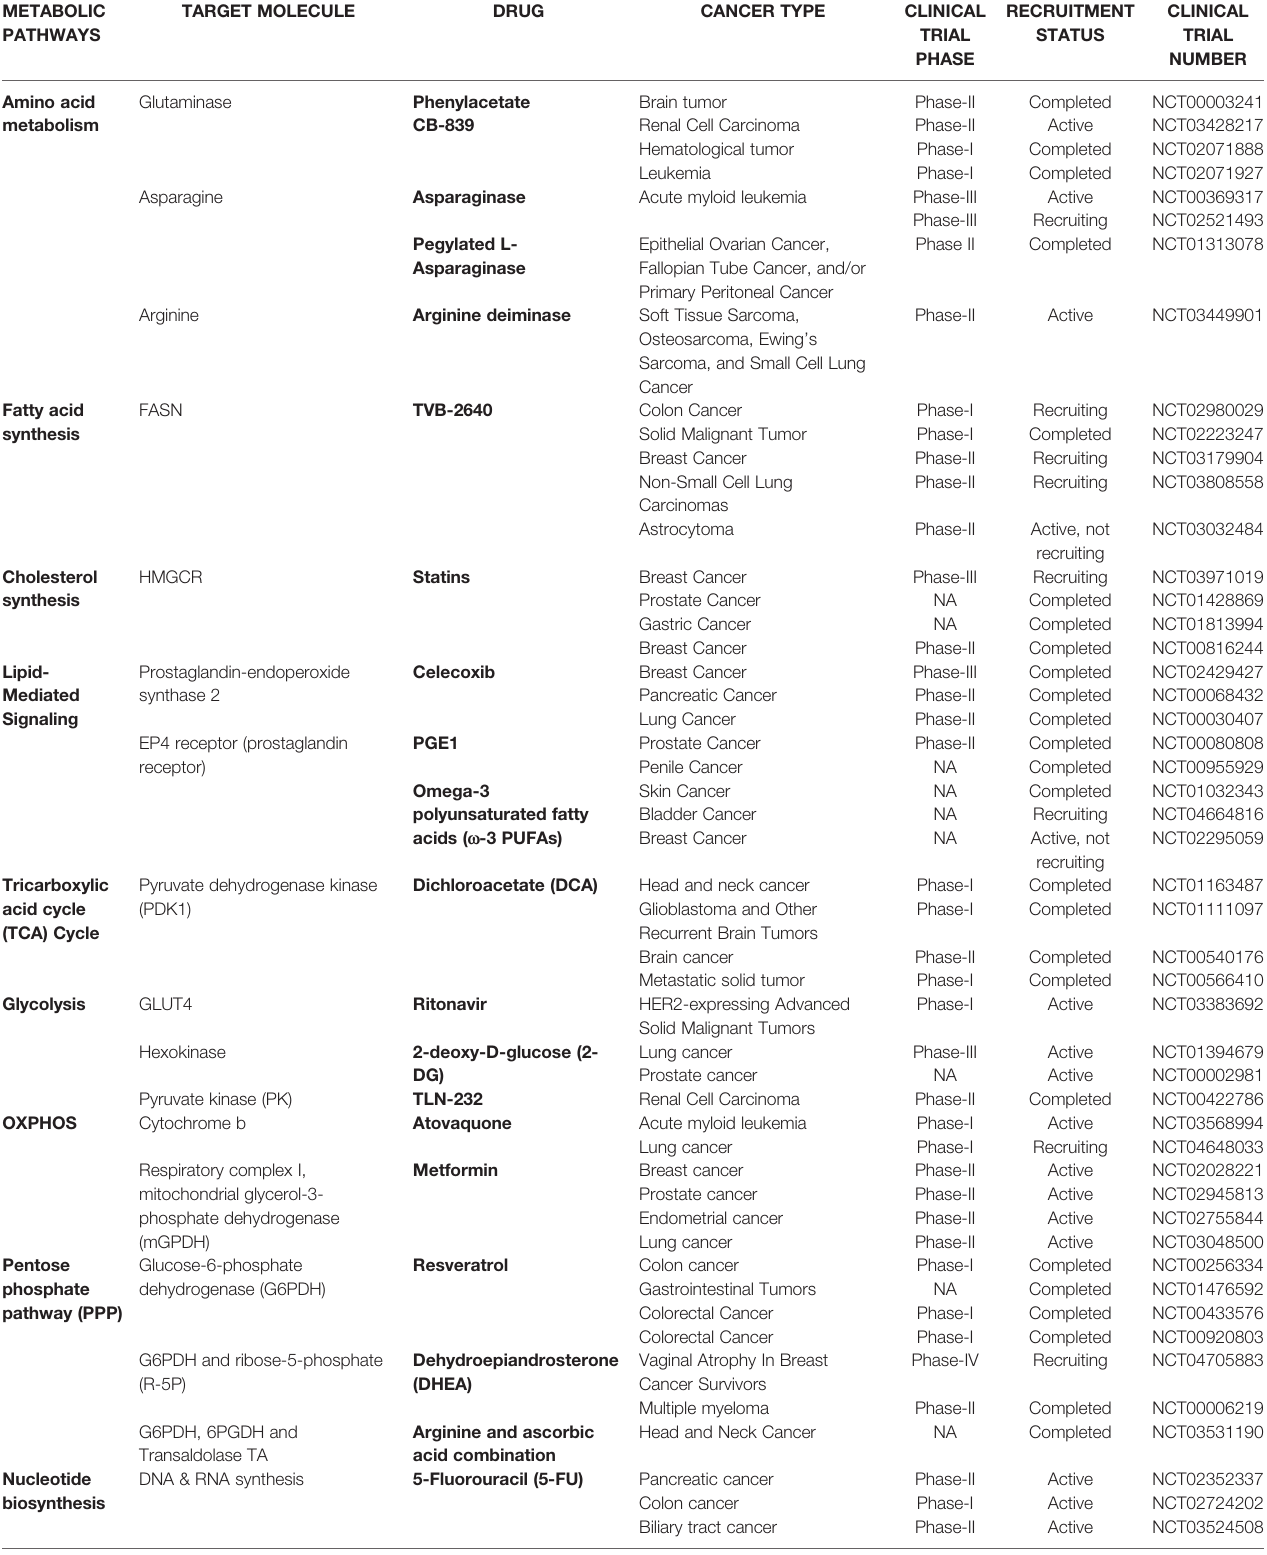
TABLE 1 | Clinical trial status of drugs targeting metabolic pathways. METABOLIC